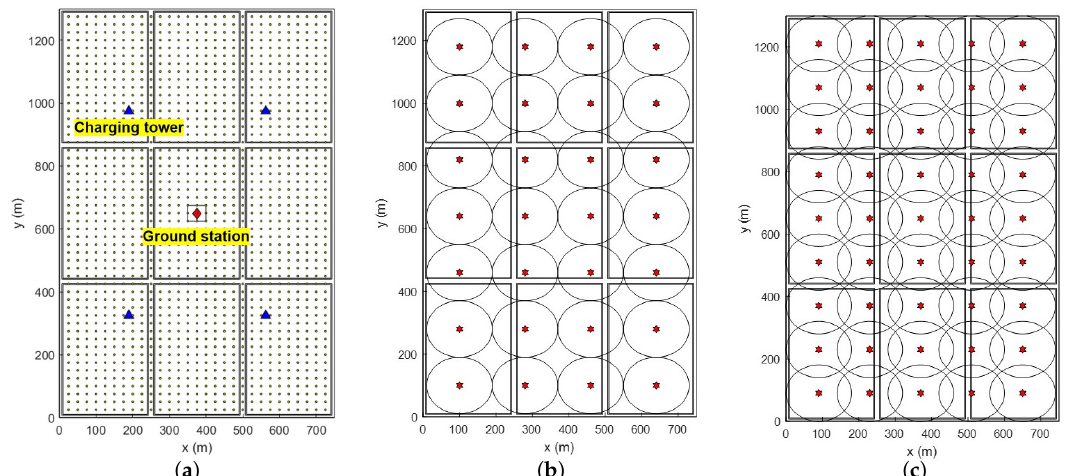
Figure 2. ( a ) 3 × 3 Manhattan grid map with four charging towers and one ground station, and 1479 reference points of 25 m intervals ( b ) Scenario 1 (sparse lattice grid): 28 fixed UAVs without overlapping areas ( c ) Scenario 2 (dense lattice grid): 45 fixed UAVs with overlapping areas.